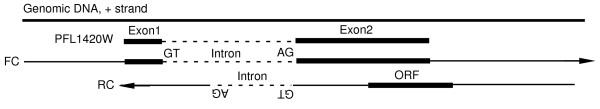
Diagram of exon/intron structures of predicted gene PFL1420w and cDNA contigs covering the gene. FC (forward contig) is a sense transcript with an intron matching the predicted intron. RC (reverse contig) is an antisense transcript having a smaller intron with GT-AG sites in the opposite direction. The line on top represents plus strand genomic DNA. Dashed lines are introns; heavy lines are predicted exons or ORF.